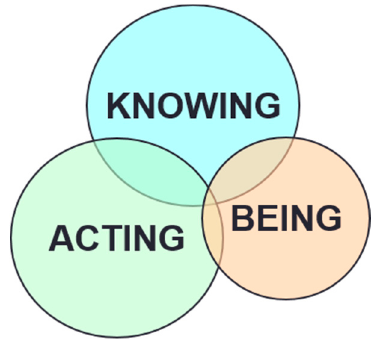
Figure 1. Educational schema as the major focus of educational designs.